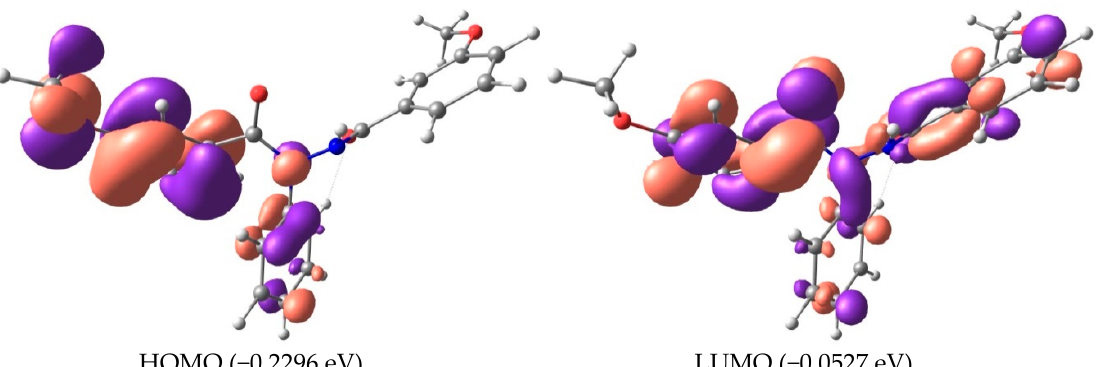
Figure 4. HOMO-LUMO surfaces of compound 1 .